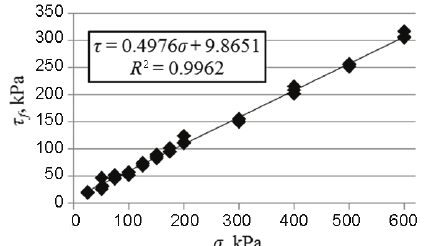
Fig. 4. Baltic sea-shore sand shearing strength maximum values